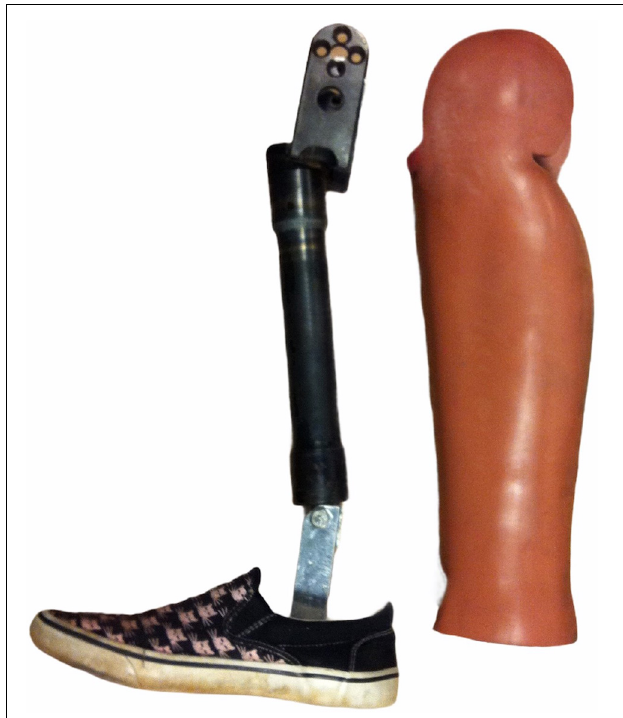
FIGURE 3 | The lower leg of the BioRID P50F prototype. FIGURE 4 | The head of the BioRID P50F